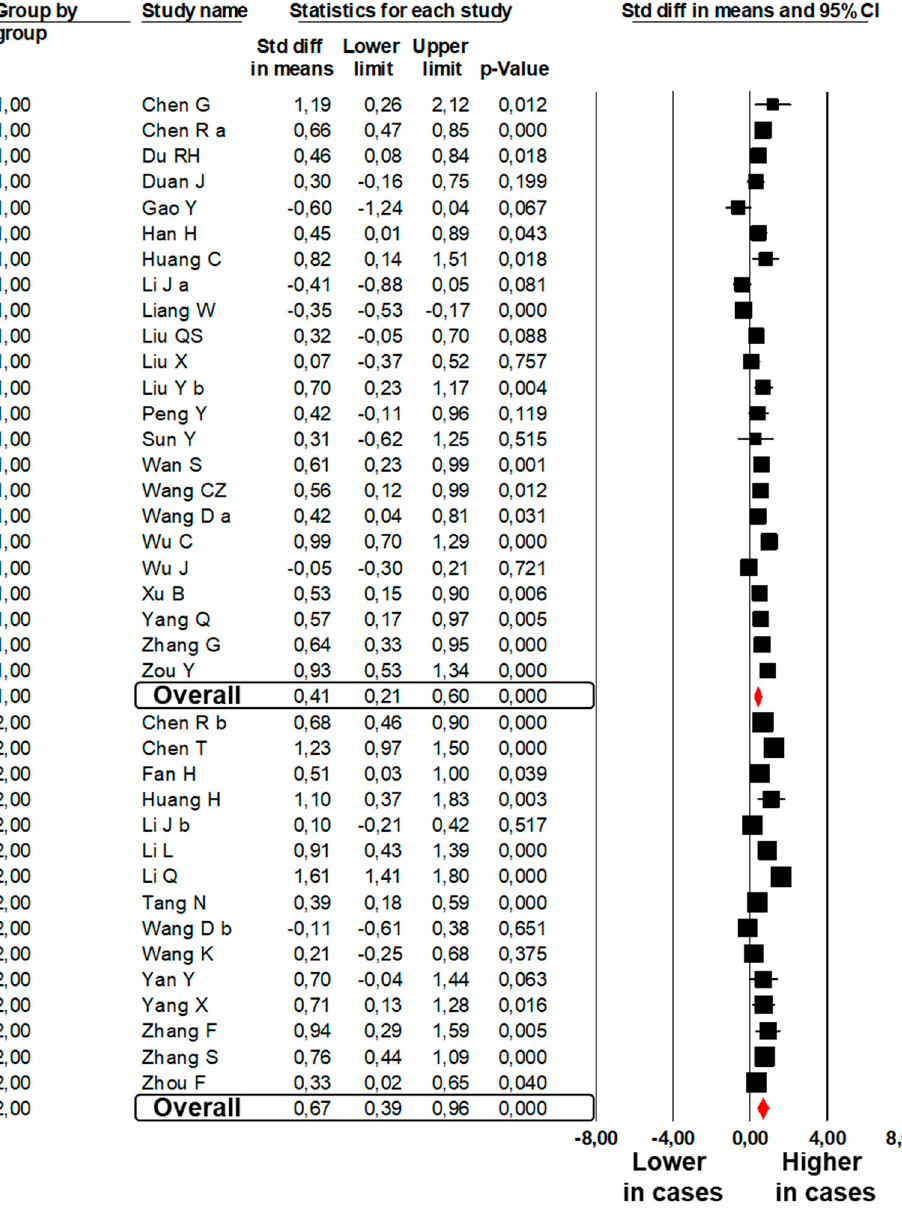
Figure 1. Forest plots of the difference in prothrombin time values between subjects with severe and those with mild COVID-19 (Group 1) and between non-survivors and survivors to COVID-19 (Group 2).